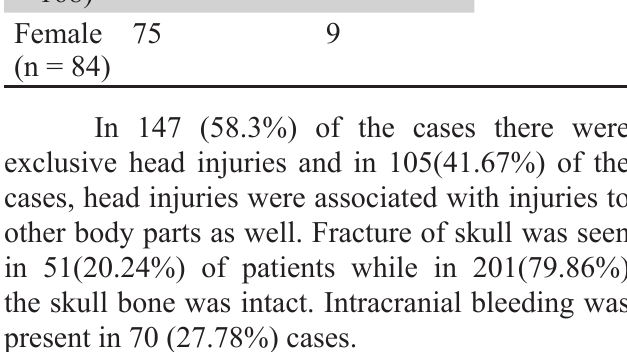
Table 3. Distribution of injuries on the parts of body other than head (n=105) Parts of the body